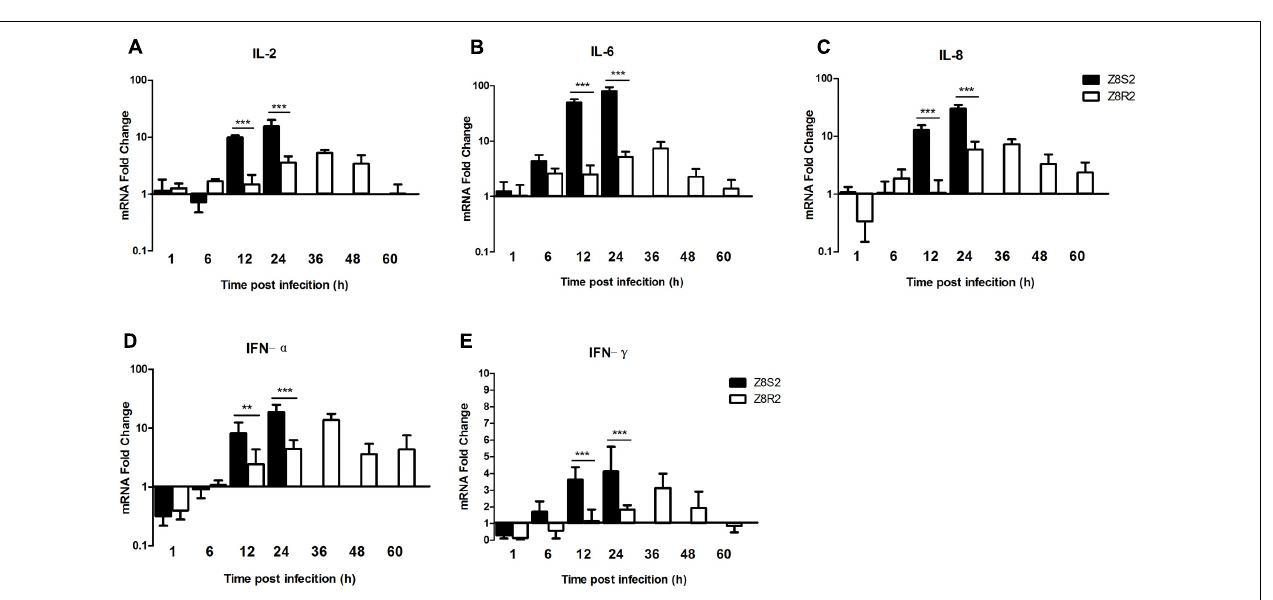
FIGURE 6 | Expression of cytokines in livers of Z8S2 and Z8R2 groups of ducklings infected with DHAV-3. Fold changes of IL-2 (A) , IL-6 (B) , IL-8 (C) , IFN- α (D) , and IFN- γ (E) were calculated using the 2 - (cid:49)(cid:49) CT method. Groups Z8S2 and Z8R2 were compared for statistical significant differences using two-way ANOVA followed by Student’s t -test. For group Z7, the samples used for detection of serum collection were employed. For groups Z8S2 and Z8R2, the samples used for detection of viral load were employed except those collected between 36 and 60 h after infection in group Z8S2. ∗∗ P < 0.01; ∗∗∗ P <